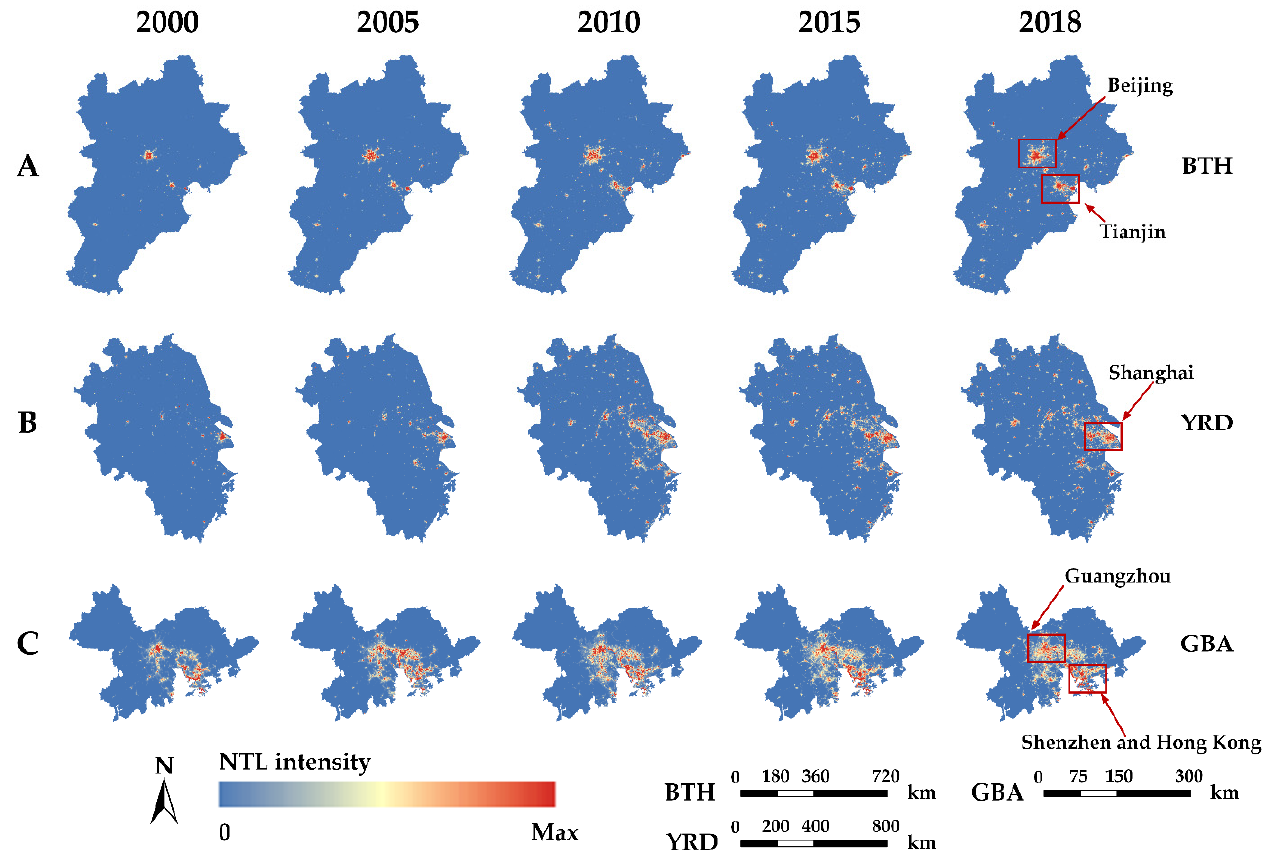
Figure 5. Extended time-series (2000–2018) nighttime light images in the three urban agglomerations. ( A – C ) represent BTH, YRD, and GBA, respectively. The arrows and rectangles represented the core cities of each urban agglomeration. The NTL intensity of each image is different. The detailed intensity values can be obtained from Section 3.1.